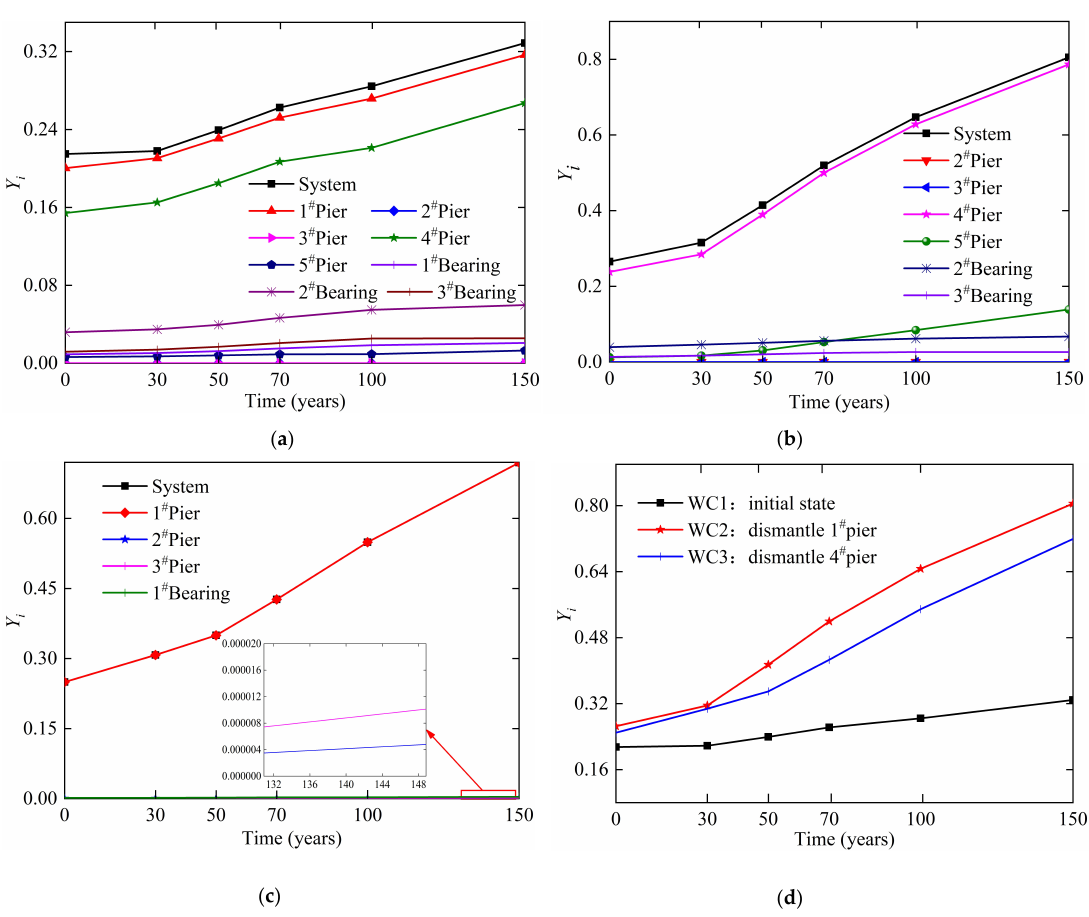
Figure 13. Time-variant fragility coe ffi cient of each working condition: ( a ) WC1; ( b ) WC2; ( c ) WC3; ( d ) Fragility coe ffi cient of the